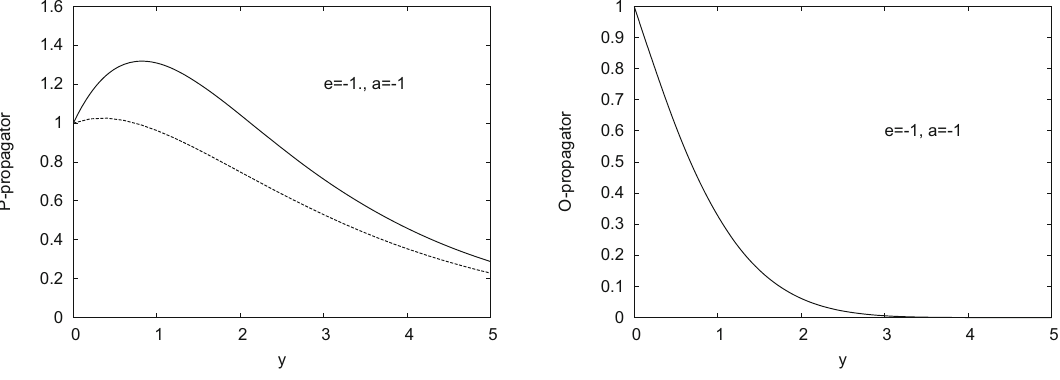
Fig. 9 The solid curves show pomeron (left panel) and odderon (right panel) propagators as functions of rapidity for μ = 1, λ = 1. The dashed curve in the left panel shows the pomeron propagator in absence of the odderon (only pomeron loops)